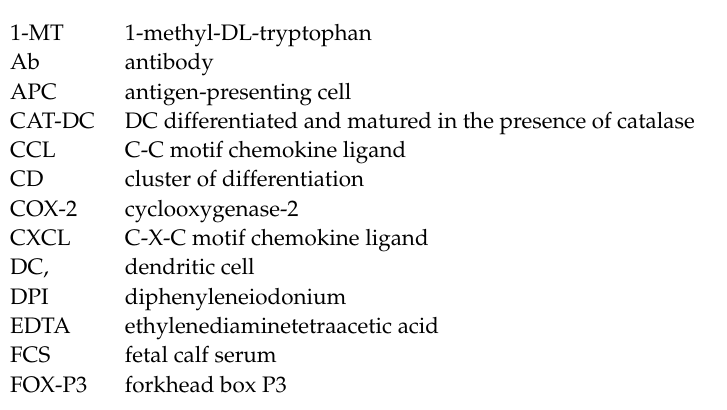
Figure S3: Raw data highlighting the representative plots as depicted in Figure 1D, Figure S4: Analysis of purified catalase on T-cell-proliferation and exemplary plots of effect of CAT-DCs on proliferation of T-cell-subtypes, Figure S5: No increased frequency of Tregsfollowing coculturewith CAT-DCs, Figure S6: Representative FACS-Plots of cytokine-profiling of T-cells for IFN γ , IL6, IL21, IL17, IL10 as described in Figure 3, Figure S7: Representative FACS-plots of Figure 5B,E–H, Figure S8: Representative FACS-plots for CD80/86-expression in CAT-DC following treatment with NOX- inhibitior and MitoQ, Figure S9: Gradual increase of PAN-T-Cell proliferation with decreasing percentage of CAT-DCs added to mDC:T-cell